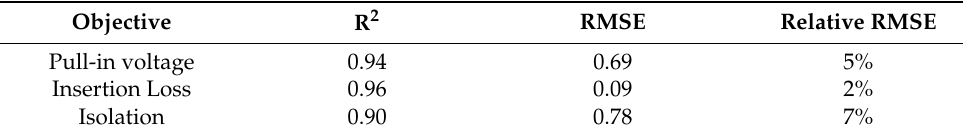
Table 4. Accuracy of meta-models of switch’s objective